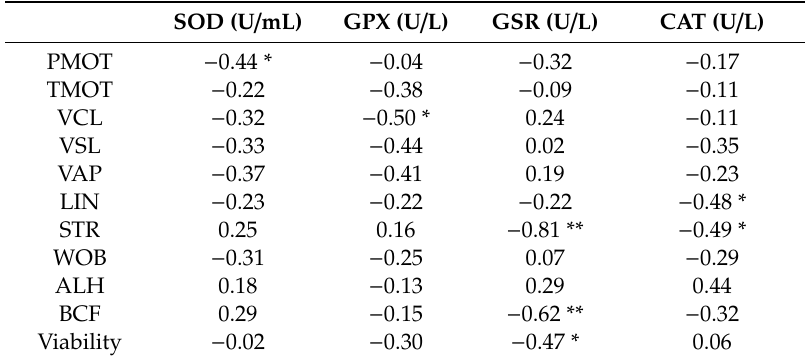
Figure 1. Superoxide dismutase activities in stallion seminal plasma (mean ± SEM): ( a ) total activity; ( b ) specific activity. Different letters (a, b) mean significant ( p < 0.05) differences between good (GFE) and poor freezability ejaculates (PFE). Table 2. Pearson correlation coefficients between total enzyme activities and post-thawed sperm quality parameters ( n = 16).